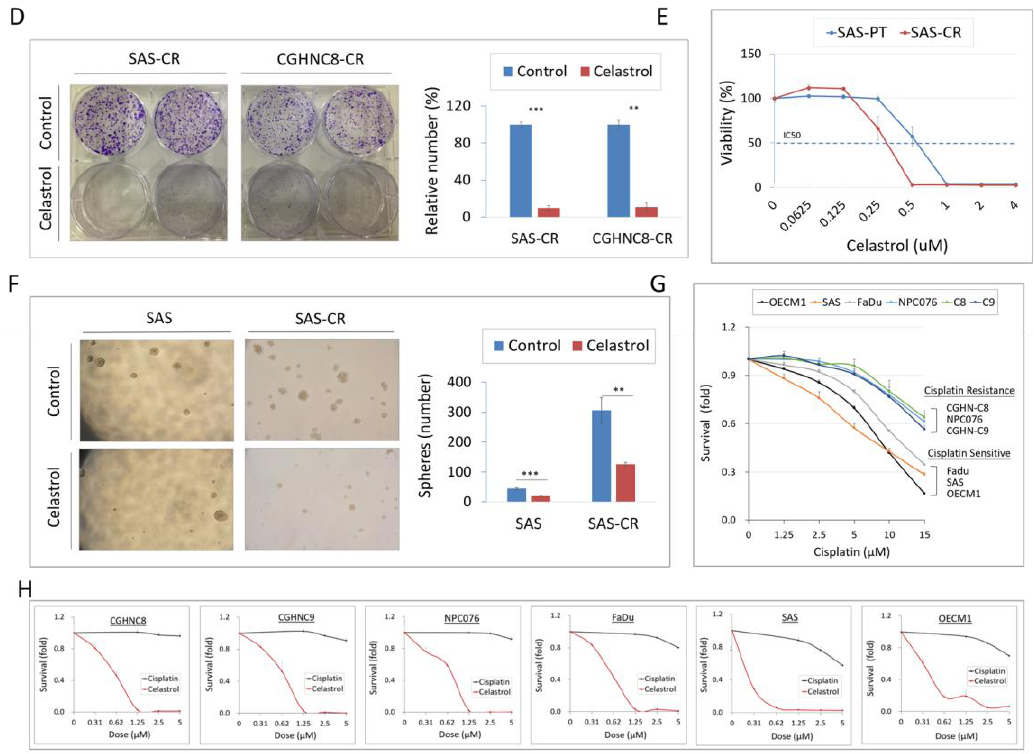
Figure 5. Connective Map (Cmap) analysis identified celastrol as a potent compound to overcome CR. ( A ) The schematic illustration of the process for exploring potential compounds to reverse CR. The CR gene signatures were used to query the Cmap database, and the compounds ranked by the enrichment score < 0 were selected. ( B ) Chemical structure of the top three negative correlated compounds queried by Cmap analysis, as cantharidin, celastrol, and GW-8510. ( C ) Assessment for the drug e ffi cacy on the CR cells. The SAS-CR and CGHNC8-CR cells were exposed to cisplatin, GW-8510, cantharidin, or celastrol at various doses for 48 h, and the cell viability was determined by MTS assay. ( D ) The e ffi cacy of celastrol on the growth suppression of CR cells, as determined by using colony formation assay. SAS-CR and CGHNC8-CR cells were treated with 0.5 µ M celastrol, following incubation for 7 days to allow colony formation. Cell colonies were stained with 5% crystal violet. ( E ) The di ff erential e ff ect of cytotoxicity by celastrol for SAS parental and SAS-CR cells. The dose–response curves with IC50 values for celastrol were established on SAS-PT and SAS-CR cells after treatment with various doses of celastrol for 2 days. ( F ) The di ff erential e ff ect of tumorsphere formation by celastrol for SAS parental and SAS-CR cells. Cells were grown in tumorsphere culture medium on ultralow attachment plates. After 14 days, tumorspheres were enumerated using microscopy. ( G , H ) The cytotoxic e ff ect of cisplatin and celastrol in a panel of HNC cell lines. CGHCN8, CGHNC9, NPC076, Fadu, SAS, and OECM1 were treated with cisplatin for 48 h, and cell viability was performed by MTS assay. p -values indicate statistical significance (** p ≤ 0.01, *** p ≤ 0.001).